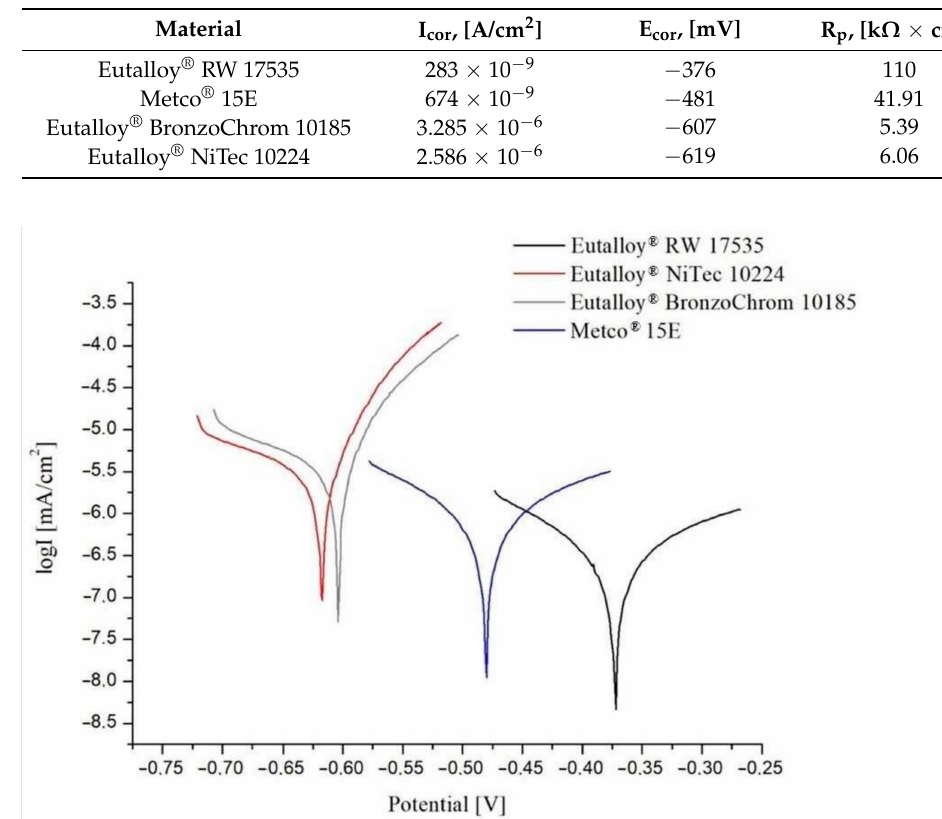
Figure 11. Potentiodynamic polarization curves of analyzed